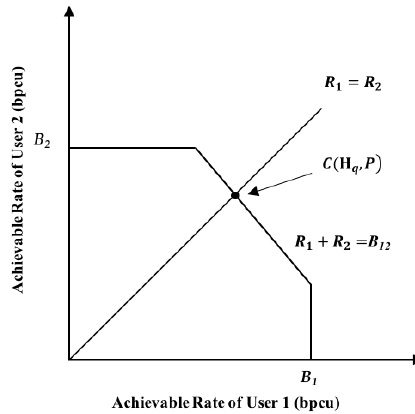
Figure 6. Capacity region of the two-user MIMO system.